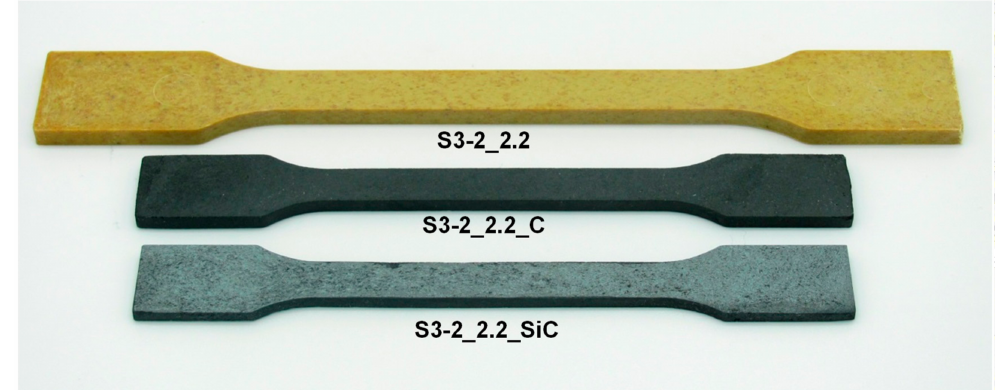
Figure 8. Comparison of a green body (top), a porous carbon template (middle), and a C / Si / SiC ceramic specimen obtained from the formulation